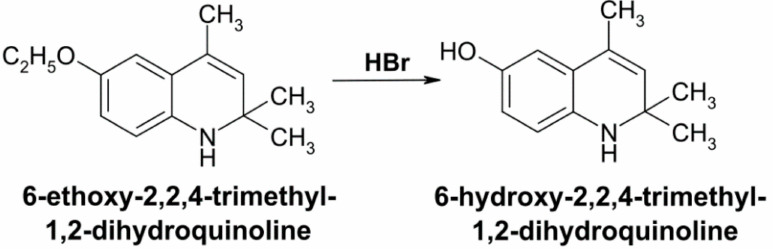
Figure 1. Synthesis of 6-hydroxy-2,2,4-trimethyl-1,2-dihydroquinoline by dealkylation of 6-ethoxy- 2,2,4-trimethyl-1,2-dihydroquinoline when exposed to hydrobromic